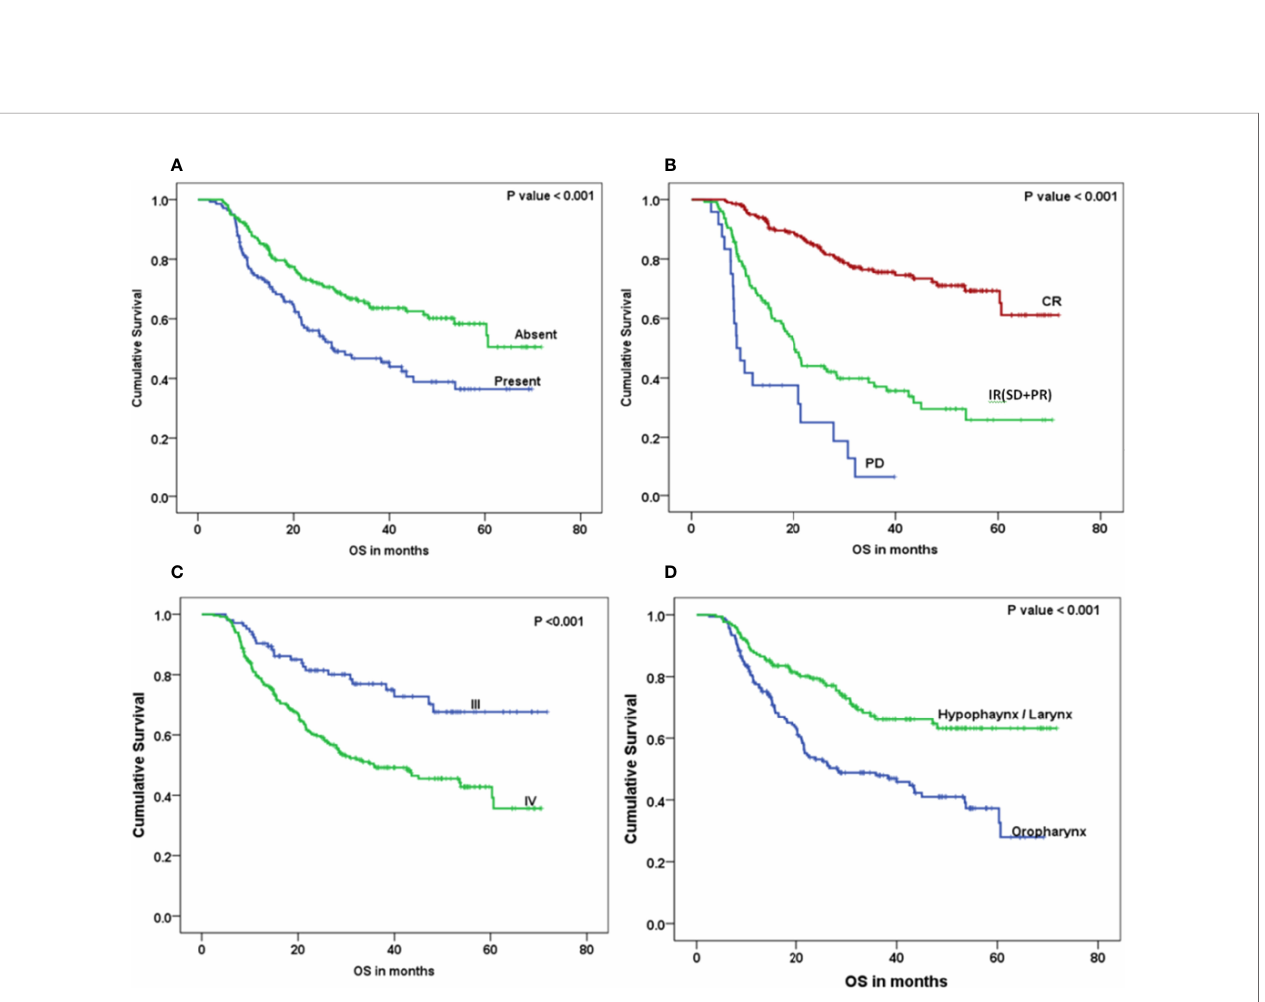
FIGURE 5 | Kaplan – Meier survival curves showing overall survival (OS) by clinical factors: (A) rENE, (B) response, (C) overall stage, and (D)